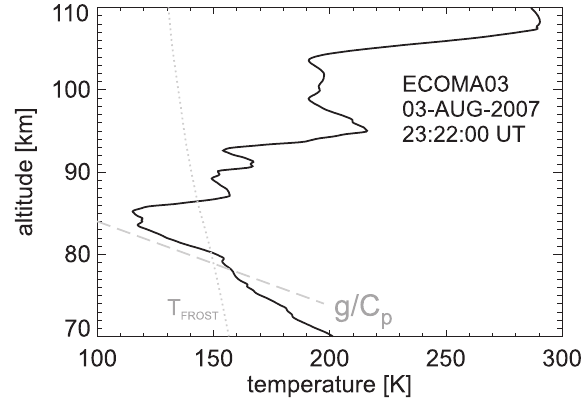
Fig. 1. Temperature measurements by CONE during ECOMA/MASS rocket campaign. The doted line shows frost point temperature derived using water vapor mixing ratio 4.5ppmv. The dashed line shows the dry adiabatic lapse rate (g/c p ) .